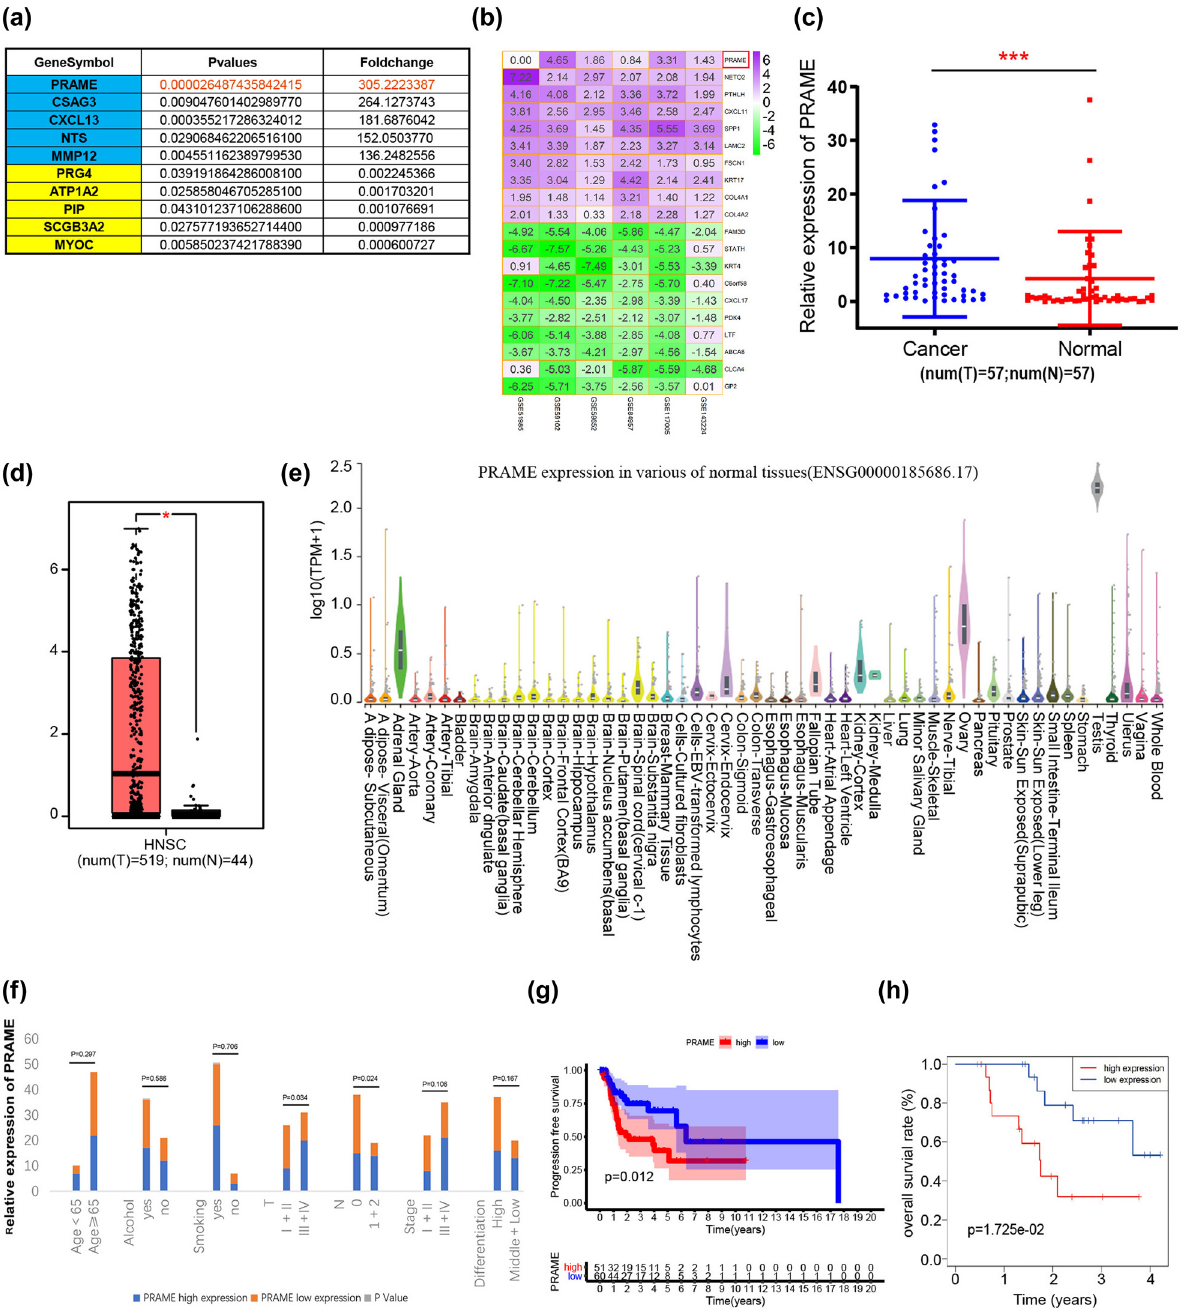
Figure 1: The expression of PRAME and its clinical signi fi cance in the LSCC patients. ( a ) PRAME, as the experimental mRNA, was selected through the microarray analysis for the further experiments. ( b ) The expression level of PRAME in transcriptome - related microarray datasets of LSCC. ( c ) PRAME expression was signi fi cantly upregulated compared with corresponding normal tissues. ( d ) PRAME mRNA levels were signi fi cantly higher in HNSC compared with paired non - tumor tissues, cited from GEPIA. ( e ) The expression levels of PRAME ( ENSG00000185686.17 ) in various normal tissues, cited from NCBI. ( f ) A high level of expression of PRAME was correlated with the TNM staging ( P < 0.05 ) as well as with lymphatic metastasis ( P < 0.05 ) . ( g and h ) Kaplan – Meier analysis showed that the progression free survival rate ( P = 0.012 ) and the overall survival rate ( P = 1.725 × 10 − 02 ) of patients in the PRAME high expression group were shorter than those of the PRAME low expression group ( * P < 0.05, ** P < 0.01, *** P < 0.001 )